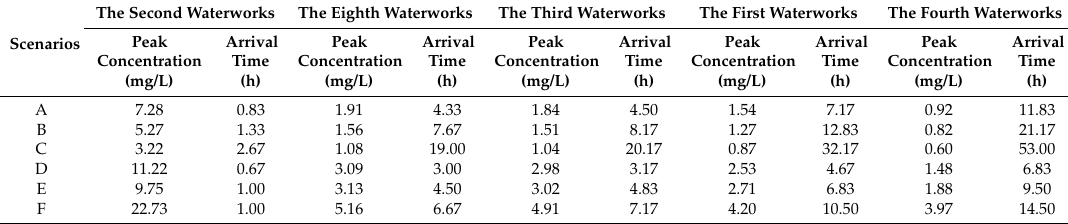
Table 3. Pollutant peak concentration and arrival time at the intakes of